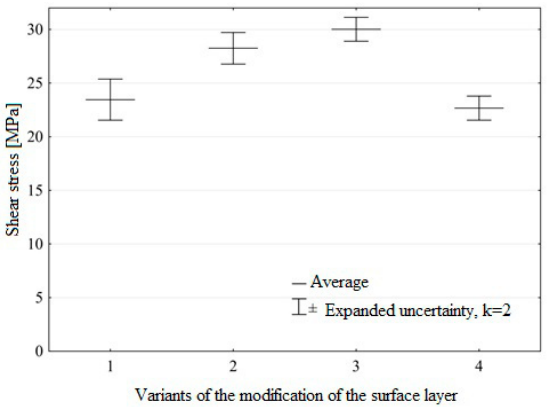
Figure 15. Shear stress at obtained in experimental studies for Ti6Al4V titanium alloy samples made with Hysol 9466 adhesive, for various ozone treatment conditions (modification variants of surface layer are described in “Materials and Methods”).